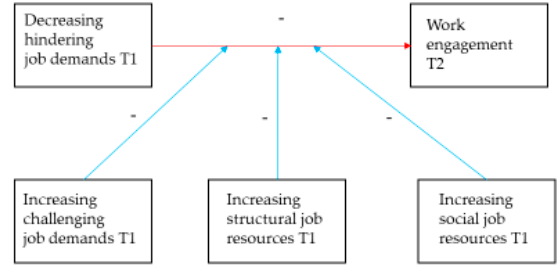
Figure 1. Investigated research model. Note. T1 = Time 1; T2 = Time 2, 18 months after T1.